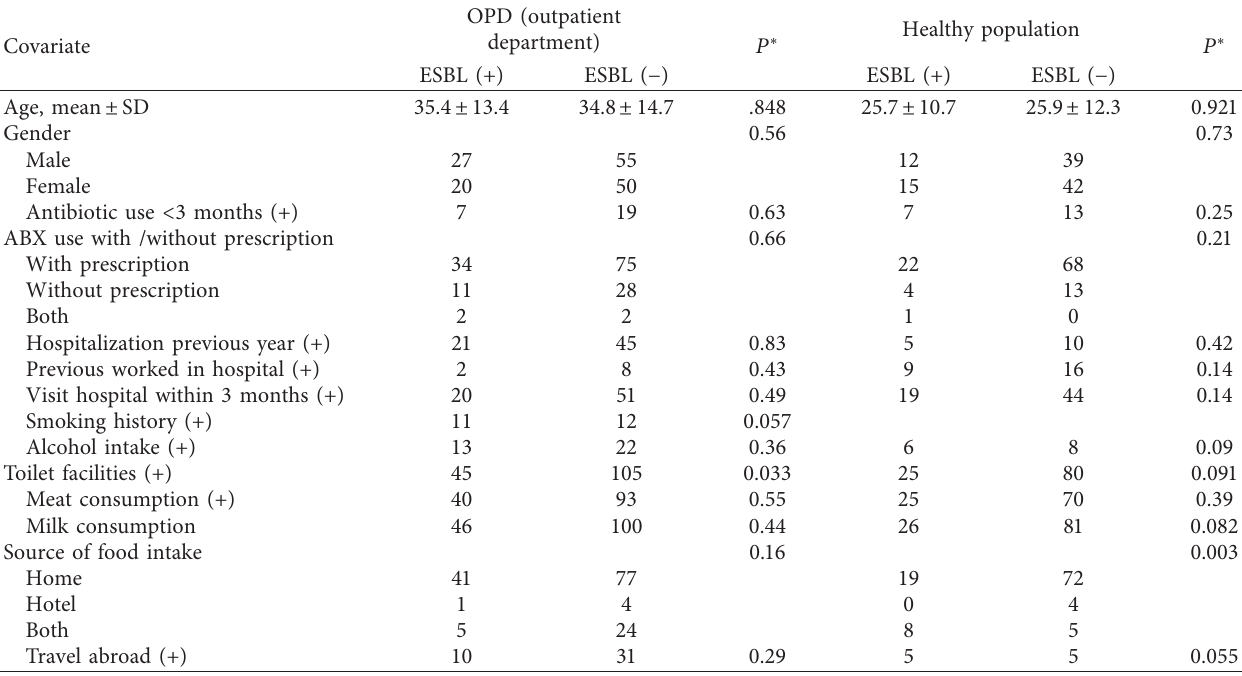
Table 4: Association among various clinical characteristics with ESBL producers and nonproducers.